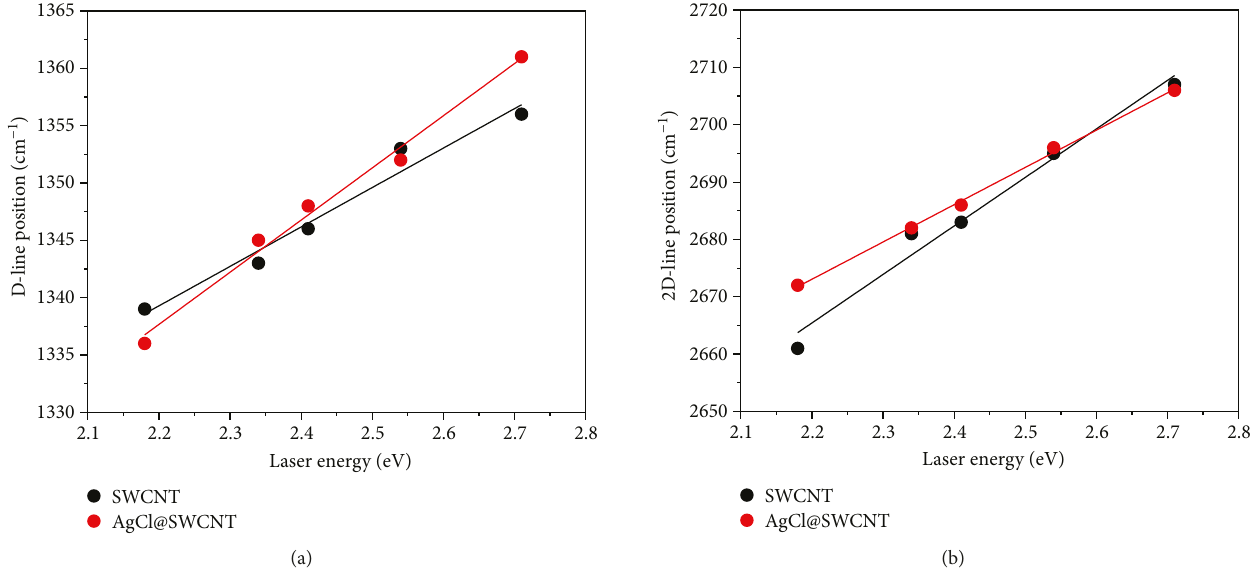
Figure 5: The positions of the D (a) and 2D (b) lines of Raman spectra of the pristine and AgCl- fi lled SWCNTs plotted versus laser energy. The experimental data are shown together with their linear fi